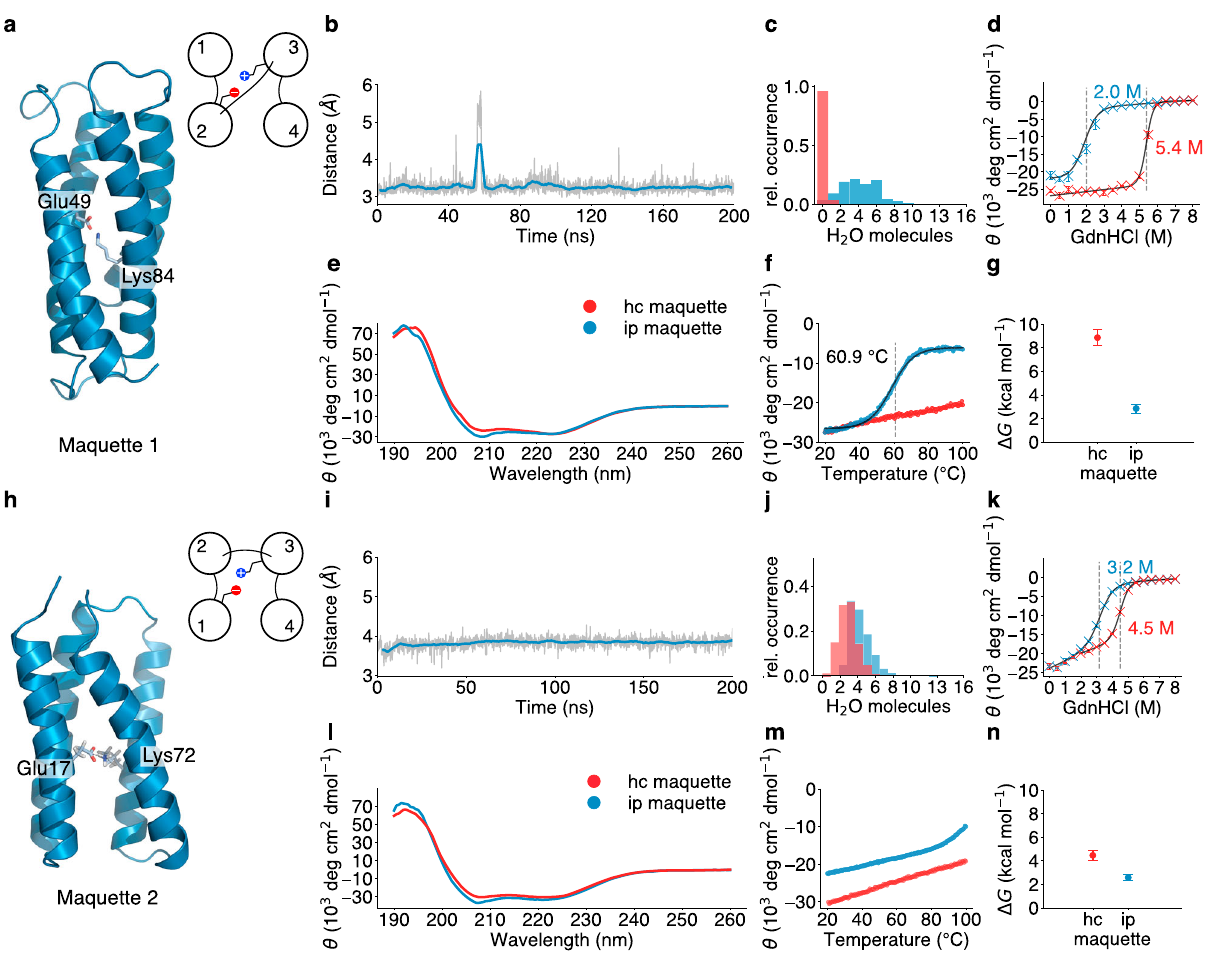
Fig. 1 Structural stability of buried ion-pairs in arti fi cial bundle proteins. a , h Structural snapshot of protein models; b , i distances between introduced ion-pairs (the shaded line represents the actual data, the coloured line is a moving average over 50 frames), and c , j number of buried water molecules during MD simulations within 9 Å of helices 1 – 4; e , l CD spectra at 20 °C of protein Maquettes 1 and 2 with a hydrophobic core (hc) and introduced ion-pair (ip); f , m melting curves measured by following the temperature dependence of the 222-nm trough in the CD spectra; d , k chemical unfolding with GdnHCl up to 8 M monitored by CD spectroscopy. Data points are presented as mean values of triplicates ( n = 3 independent experiments) with ±standard deviation shown as error bars; and g , n thermodynamic stability ( Δ G ) values calculated from the chemical unfolding experiments, with error bars computed from the standard deviation of the chemical unfolding pro fi